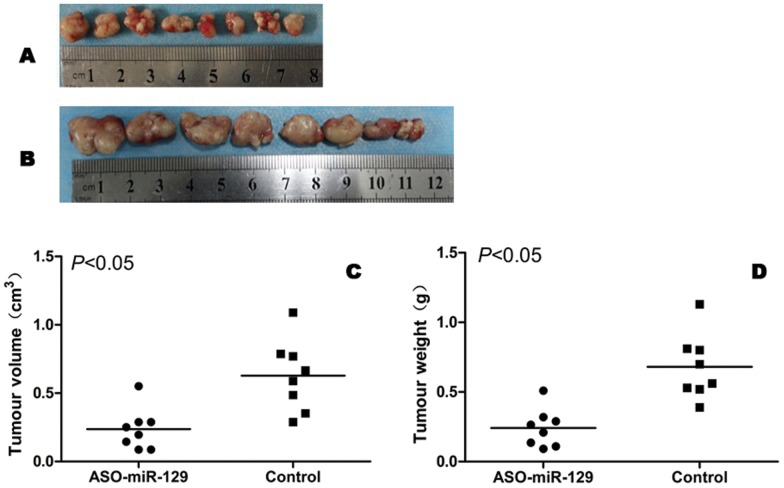
ASO-miR-129-5p inhibits the growth of LSCC tumours in vivo.(A) Tumours in ASO-miR-129-5p group. (B) Tumours in the GFP group. (C) The difference in tumour volumes between the ASO-miR-129-5p group and control (P<0.05). (D) The difference in tumour weights between the ASO-miR-129-5p group and control (P<0.05).